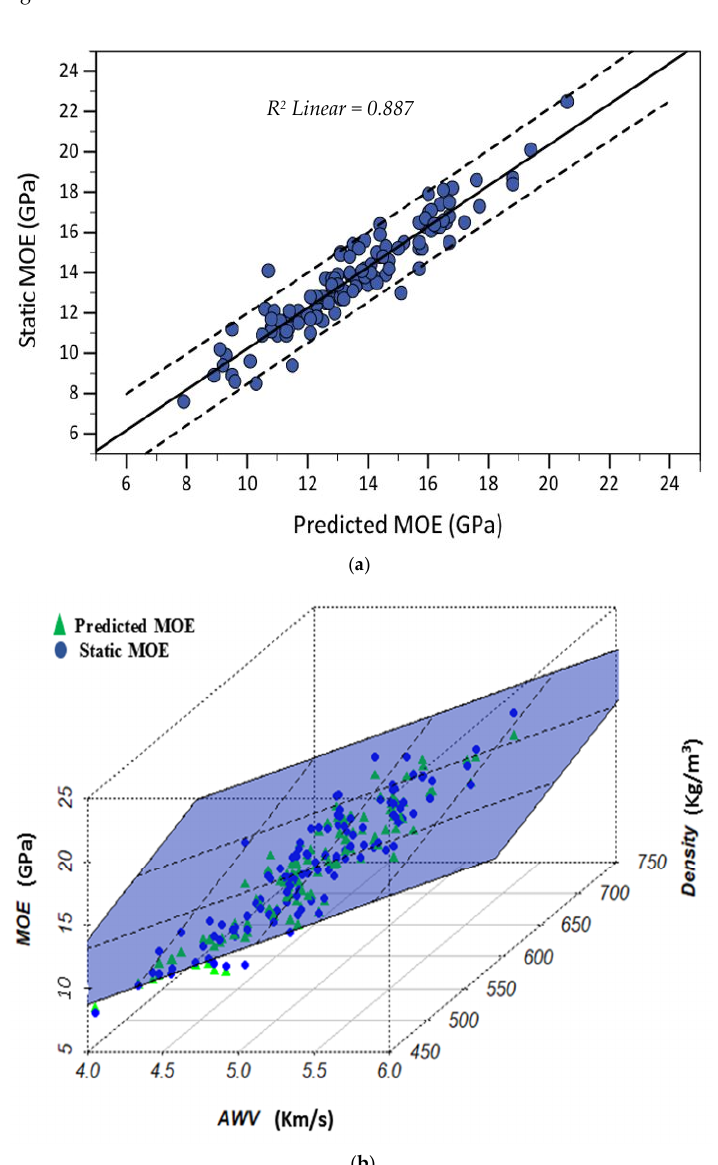
Figure 11. Correlation between the predicted MOE and static MOE values ( a ) Three-dimensional scatter plot of AWV, density and MOE values of the boards ( b ) .